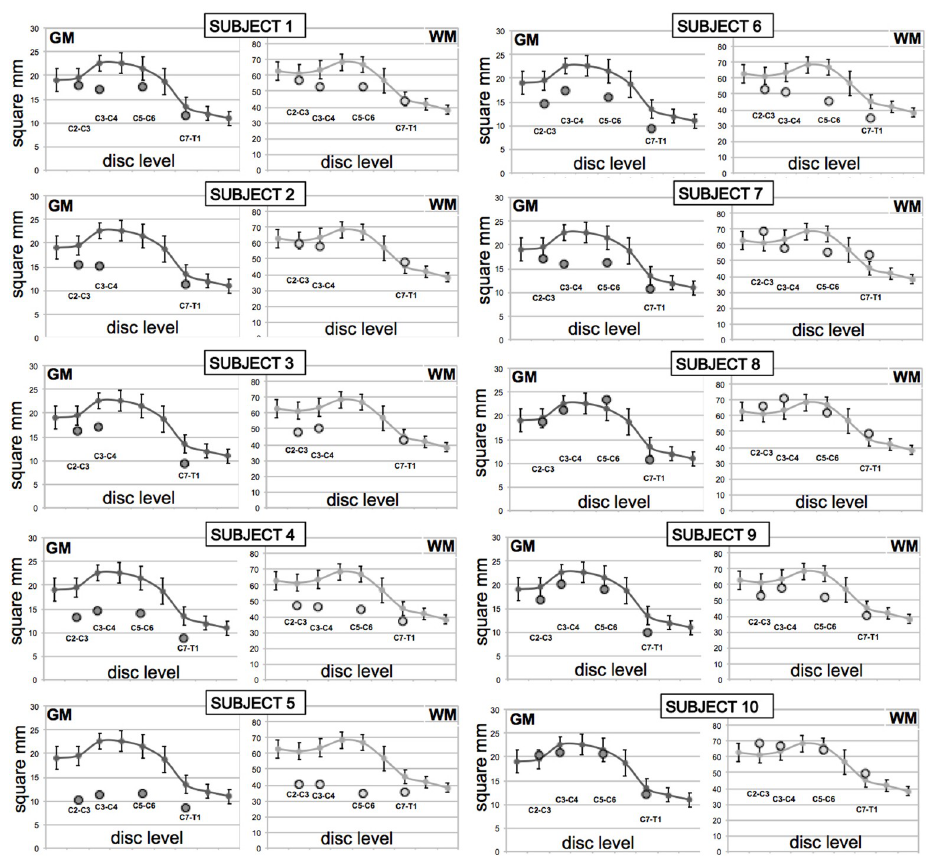
Fig 2. Spinal cord gray (GM) and white matter (WM) areas of individual motor neuron disease (MND) patients. GM and WM areas of the 10 MND patients (subject 1–10) at the four cervical levels (circles) compared to 10 healthy controls (solid line, data from Papinutto 2015[28]). Whiskers represent standard deviations. https://doi.org/10.1371/journal.pone.0208255.g002 Table 4. Individual spinal cord gray (GM) and white matter (WM) areas of the 10 motor neuron disease (MND) patients. Patient #